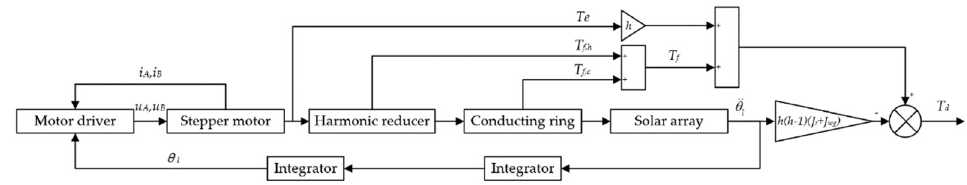
Figure 13. Schematic diagram of the disturbance torque simulation.